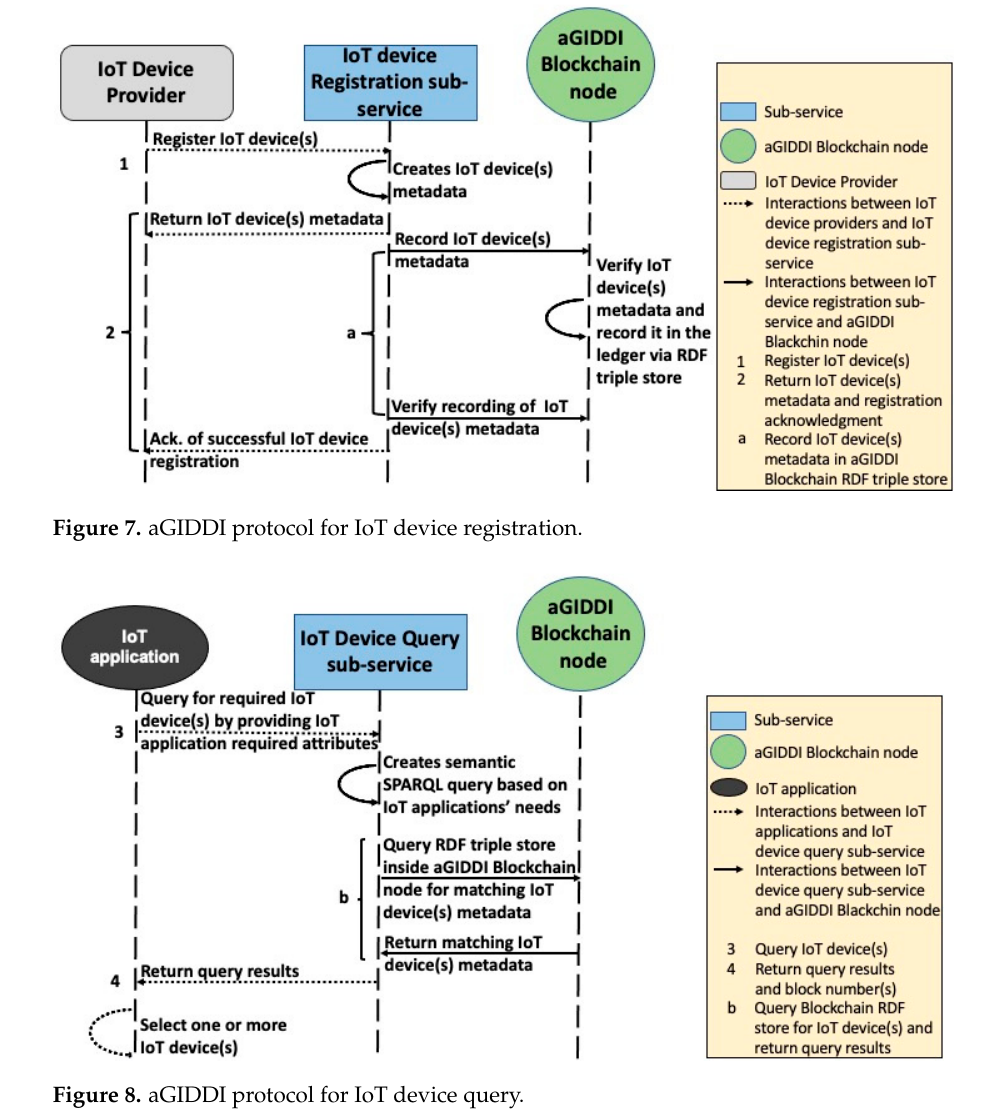
Figure 7. aGIDDI protocol for IoT device registration.